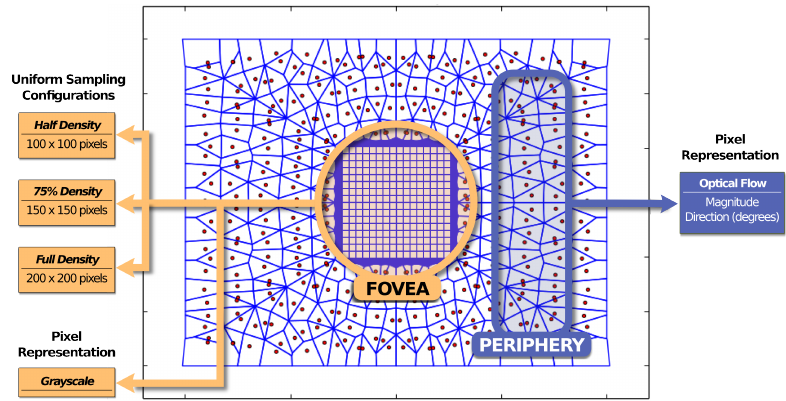
Figure 8. The pixel map of the evaluated ARIM and its configurations. The experimented foveal configurations comprised three uniform sampling setups: 100 × 100 (half density), 150 × 150, and 200 × 200 (full density) pixels. The pixel representations for the fovea and periphery were based on the grayscale and optical flow (magnitude and direction) values,